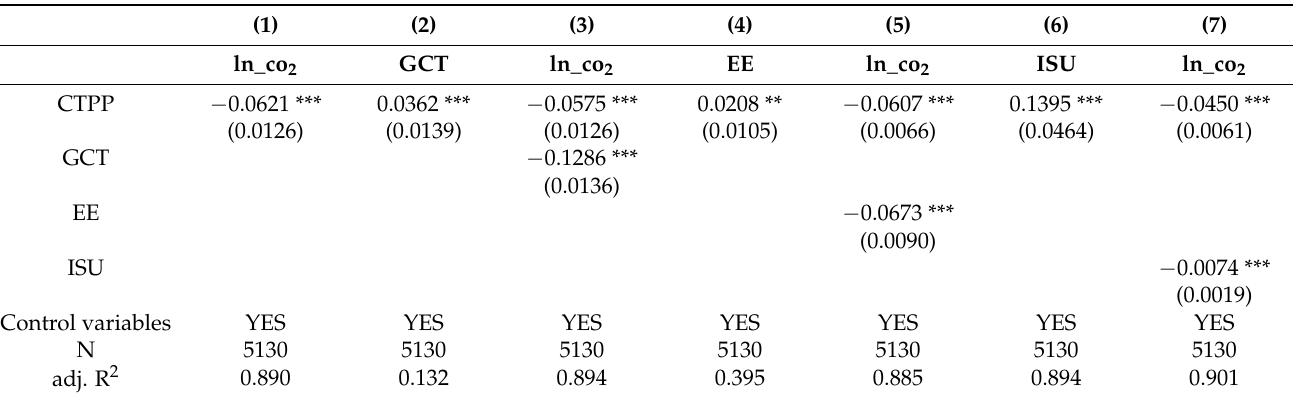
Table 8. Regression results of mediating mechanism